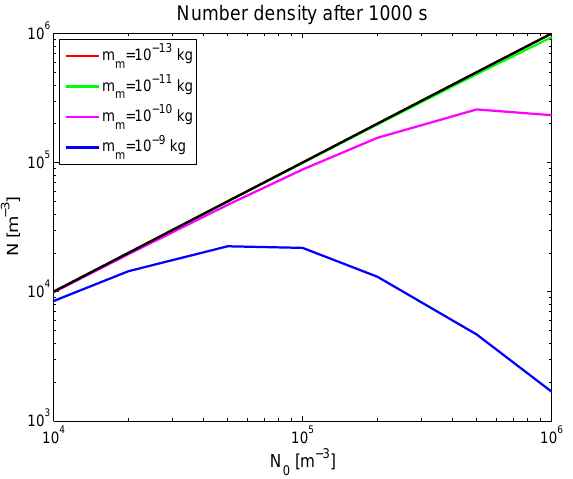
Fig. 5. Particle number density N 0 at the beginning of the iteration (x-Axis) and after 1000 s of iteration (N, y-Axis) for a modal mass of 10 − 9 kg, which corresponds to a particle with modal length 345 µ m. As a reference for no aggregation, a black line is plotted. Adding a temperature dependency shows a weakened aggregation effect with decreasing temperatures. The lower the temperatures the more particles are present at the end of the simulation.